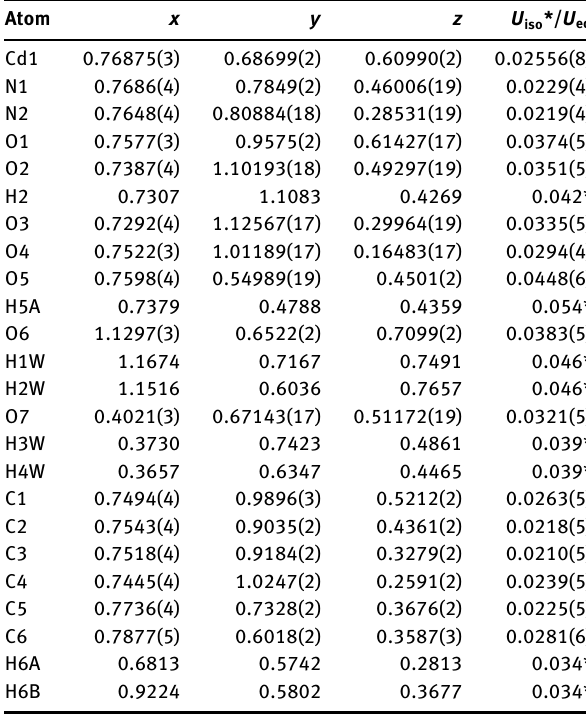
Table 2: Fractional atomic coordinates and isotropic or equivalent isotropic displacement parameters (Å 2